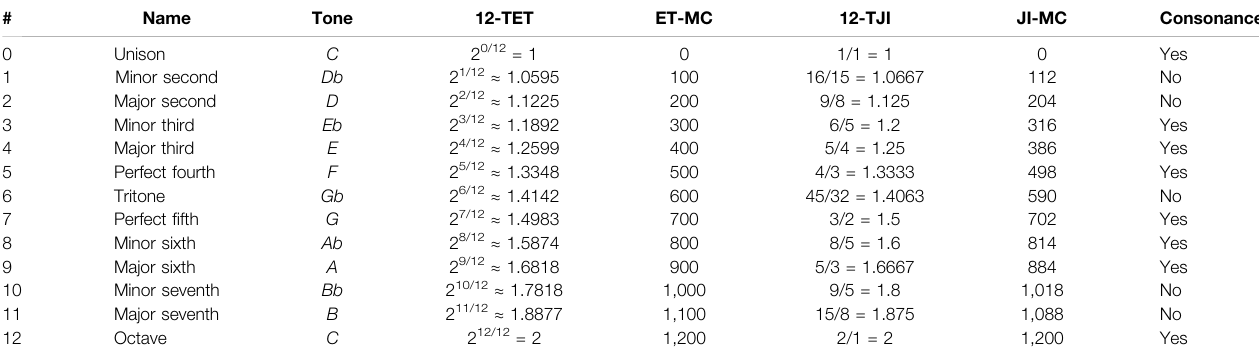
TABLE 1 | Numerical values of the musical tones (in the key of C ) of the equally tempered 12-TET and the justly tuned 12-TJI systems; their musical cents (MC) values evaluated with Eq. 5 ; and whether or not they form a